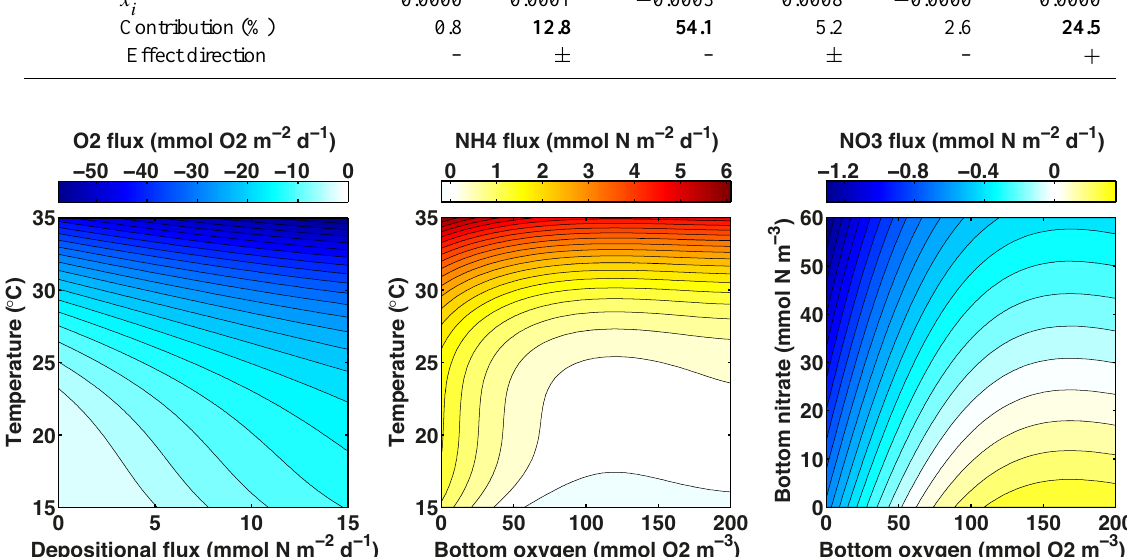
Figure 7. Influence of selected contributors to O 2 , NH + fluxes (orange shades) are out of the